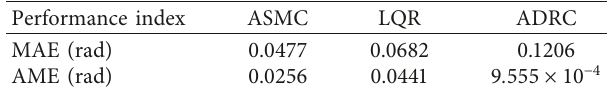
Table 5: Comparison of the roll tracking performance under the wind speed of 2.8